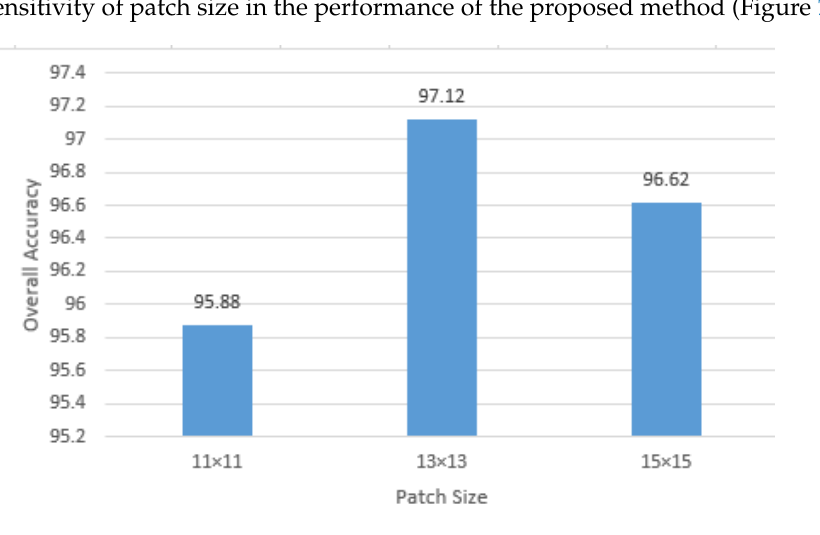
Figure 7. Performance of proposed rice-mapping framework as a function of the patch size.